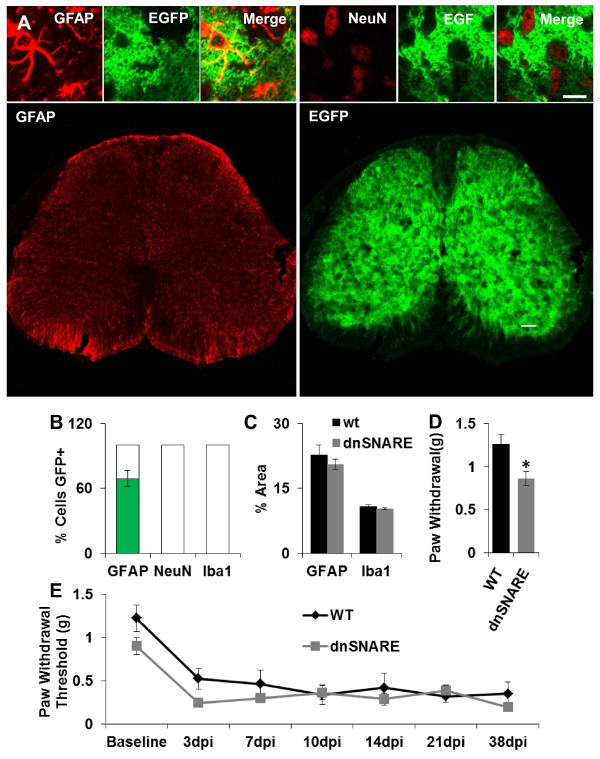
Astrocyte Specific Attenuation of Gliotransmission Causes Reduced Basal Nociception but Does Not Alter NPP. (A) The lumbar spinal cord exhibits abundant expression of EGFP reporter protein (green) with distinct colocalization with the astrocyte marker, GFAP (red; left), but not with the neuronal marker NeuN (red; right). (B) Quantification of EGFP+ cells reveals that 69.2 ± 7.3% GFAP+ cells were EGFP+ in dnSNARE mice but 0% colocalization was present Iba1+ or NeuN+ cells. No EGFP+ cells were found in WT sections (not shown). (C) dnSNARE expression does not cause reactive astrocytes or microglia as shown by similar GFAP (WT: 22.7 ± 2.4% n = 3; dnSNARE: 20.6 ± 1.2% n = 3; P = 0.24) and Iba1 (WT: 10.7 ± 0.5% n = 3; dnSNARE: 10.3 ± 0.2% n = 3; P = 0.20) staining between dnSNARE and WT dorsal horns. (D) DnSNARE mice exhibit a significant reduction in baseline paw withdrawal thresholds compared to WT mice (WT: 1.24 ± 0.13 n = 18, dnSNARE: 0.86 ± 0.08 n = 21 *P < 0.01). (E) DnSNARE and WT mice both exhibit sustained reduction in paw withdrawal threshold after SNI with no significant difference between WT and dnSNARE (WT: n = 9 for 3-21 dpi, n = 7 for 28 dpi dnSNARE: n = 12 for 3-21 dpi, n = 7 for 28 dpi P = 0.570). Scale bars: 10 μm (upper); 100 μm (lower). dpi, days post injury.